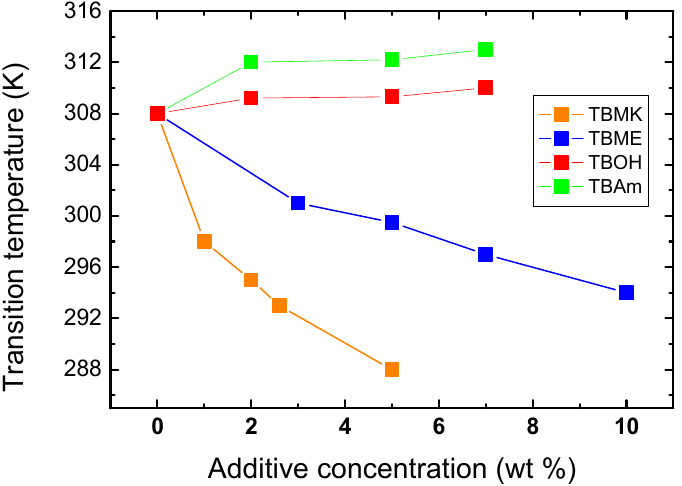
Figure 4. Concentration dependence of the transition temperature for PVME/additives solutions ( c P = 5 wt % PVME in D 2 O).